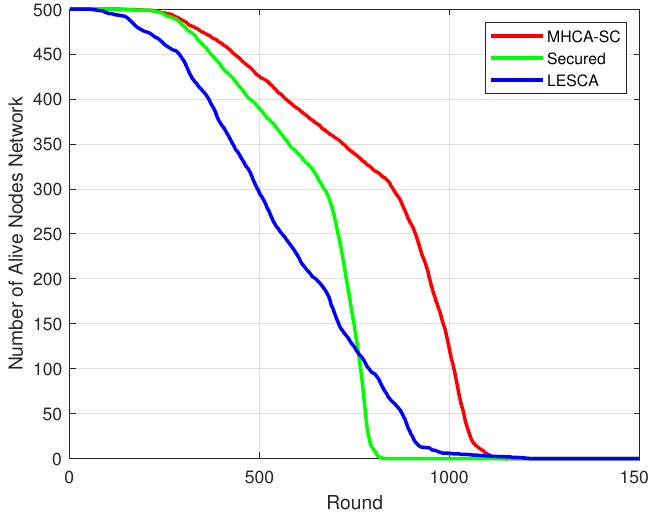
Figure 12. FDN: LESCA vs. SMHCA-CS vs. MHCA-CS (500 Nodes).